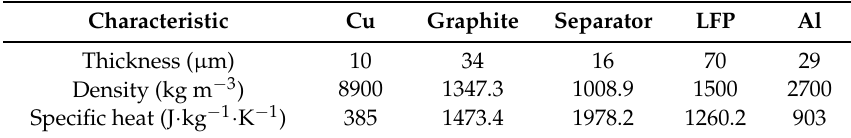
Table 1. Several properties of commercial graphite/LiFePO 4 (C/LFP) 2.3Ah materials. Characteristic